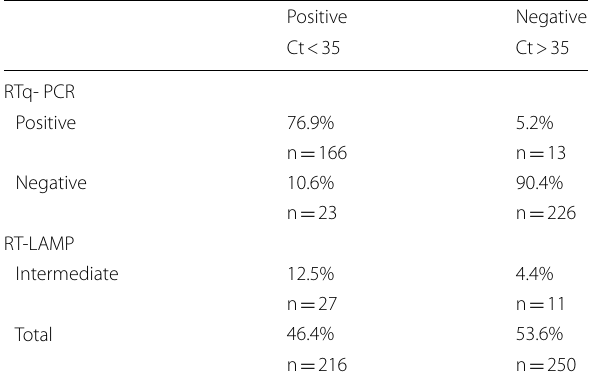
Table 1 Summary of RT-LAMP results testing 466